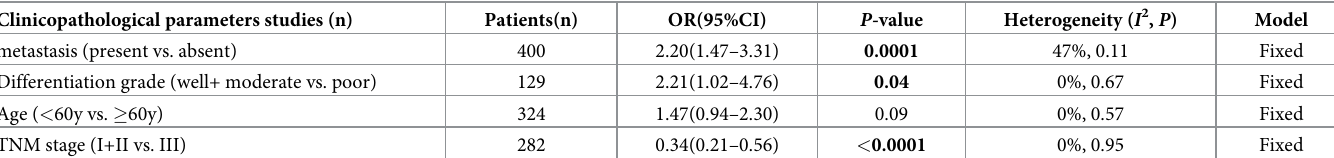
Table 3. Association of EWSAT1 expression with clinicopathological features.